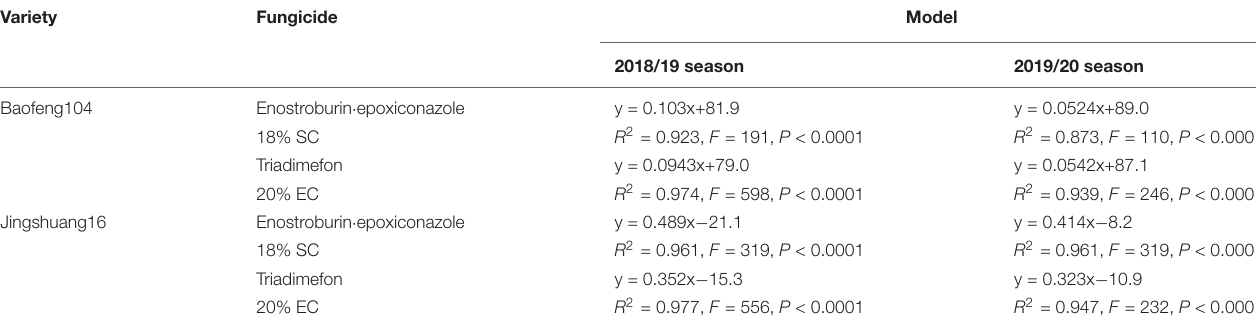
TABLE 7 | The relationship models between control efficacies and active ingredient dosages of two fungicides on different varieties in two growing seasons. Variety Fungicide